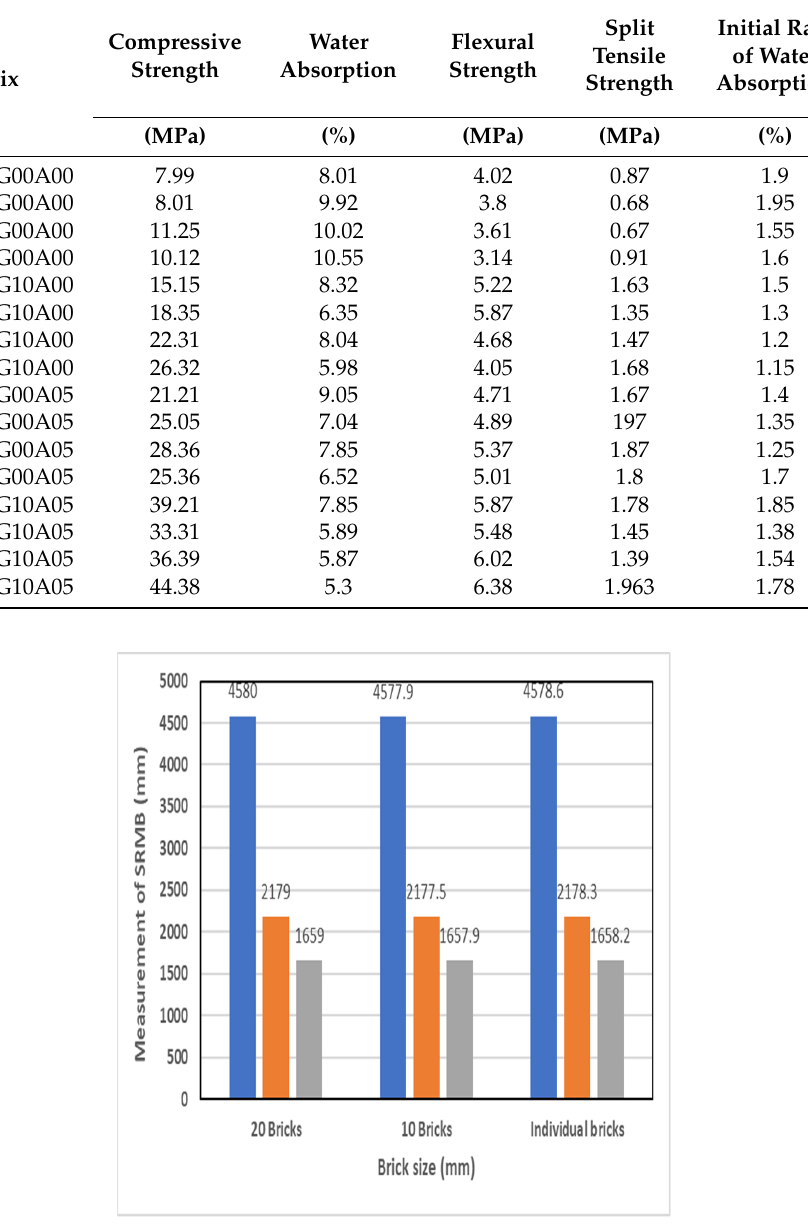
Figure 13. SRMB immersed in water.